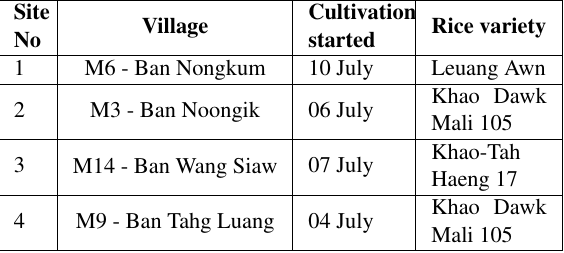
Table 1: Summary of the field data collection sites